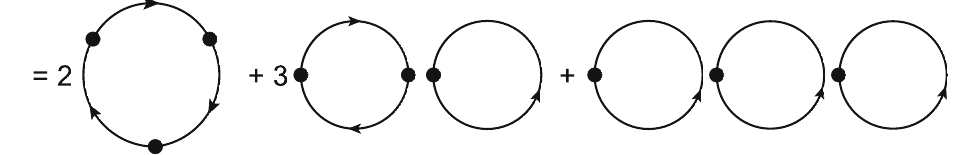
(cid:2) (cid:3) N 3 . The point represents the vertex and the line represents the quark propagator